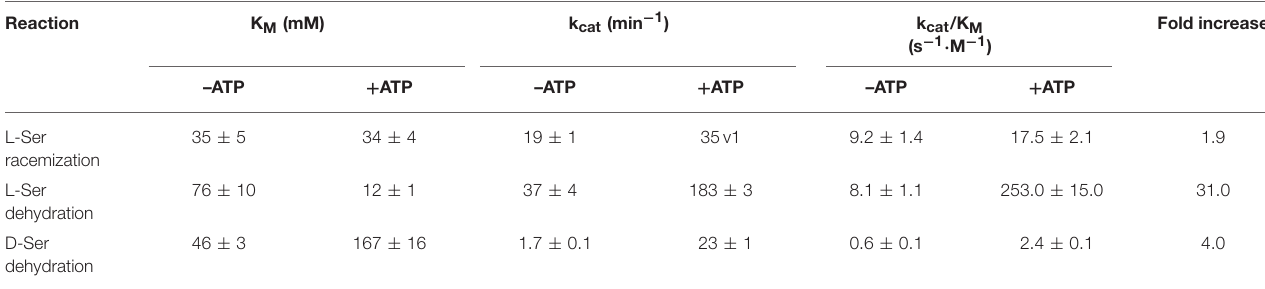
TABLE 2 | Catalytic parameters of hSR for serine racemization and dehydration in the presence and absence of ATP, at saturating concentrations of Mg 2 + .